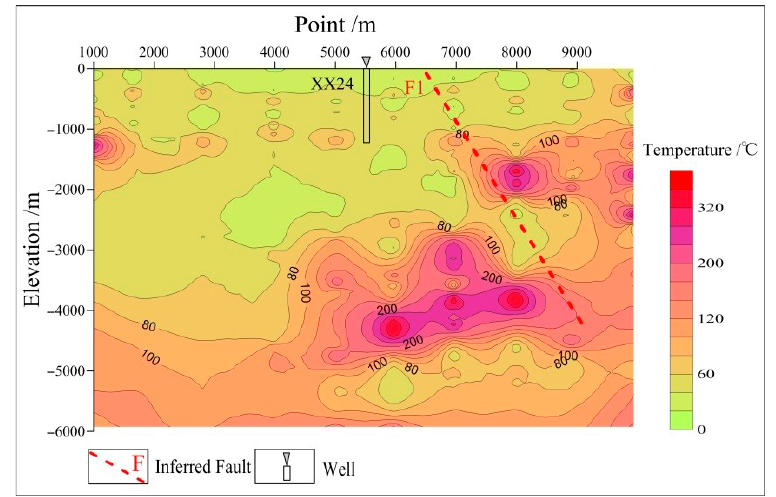
Figure 8. Temperature profile of survey line L1.